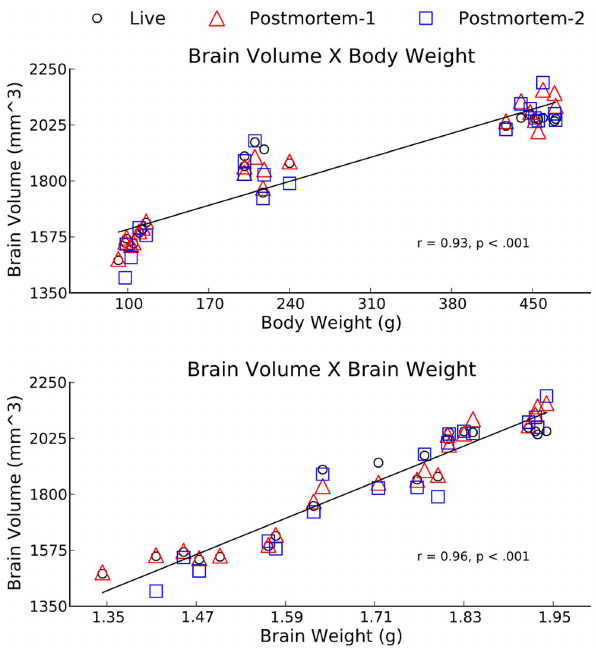
Figure 3. Pearson’s correlation between brain volume, brain weight and body weight.